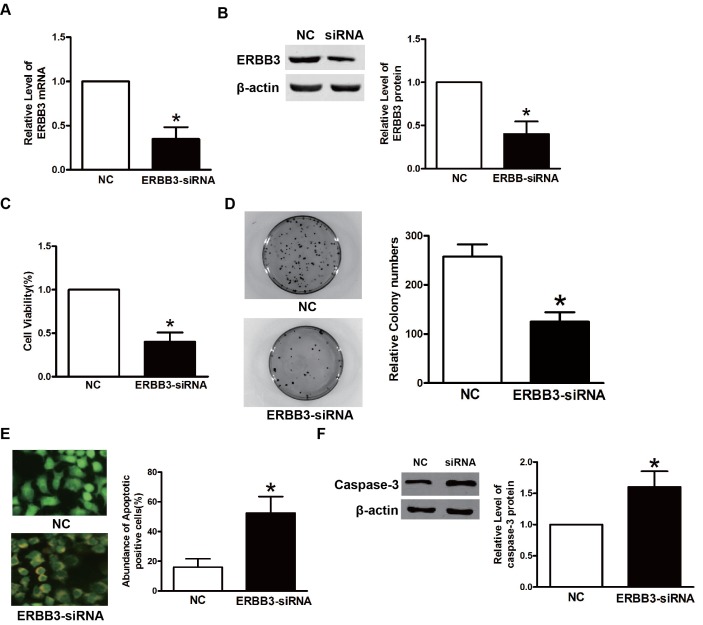
Downregulation of ERBB3 by specific siRNAs inhibits proliferation and colony formation of TPC-1 cells.A. The mRNA expression of ERBB3 in TPC-1 cells transfected with ERBB3-siRNA or NC. β-Actin served as an internal control. *P<0.05. B. The protein expression of ERBB3 in TPC-1 cells transfected with ERBB3-siRNA or NC. β-Actin served as an internal control. C. The MTT assay TPC-1 cells transfected with ERBB3-siRNA or NC. *P<0.05. D. The colony formation assay of TPC-1 cells transfected with ERBB3-siRNA or NC. *P<0.05, E. The acridine range/ethidium bromide ratio was used to determine the apoptosis of TPC-1 cells. F. The expression of caspase-3 in TPC-1 cells after treatment with NC or ERBB3-siRNA.*P<0.05.